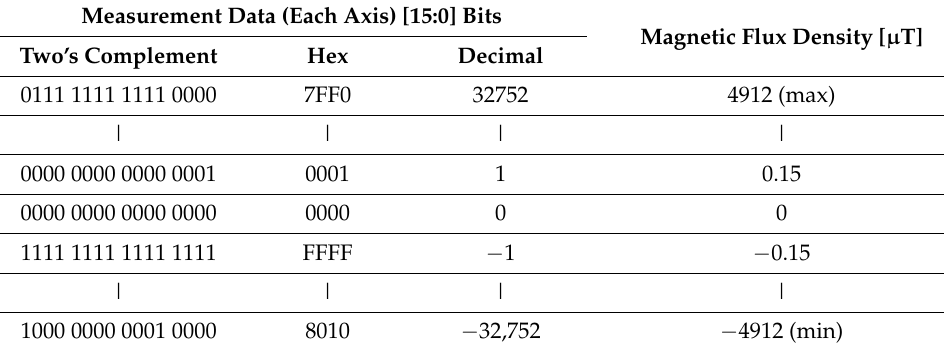
Figure 3. Flow chart of the indoor localization algorithm combining PDR and fingerprinting. Table 1. Magnetometer measurement data